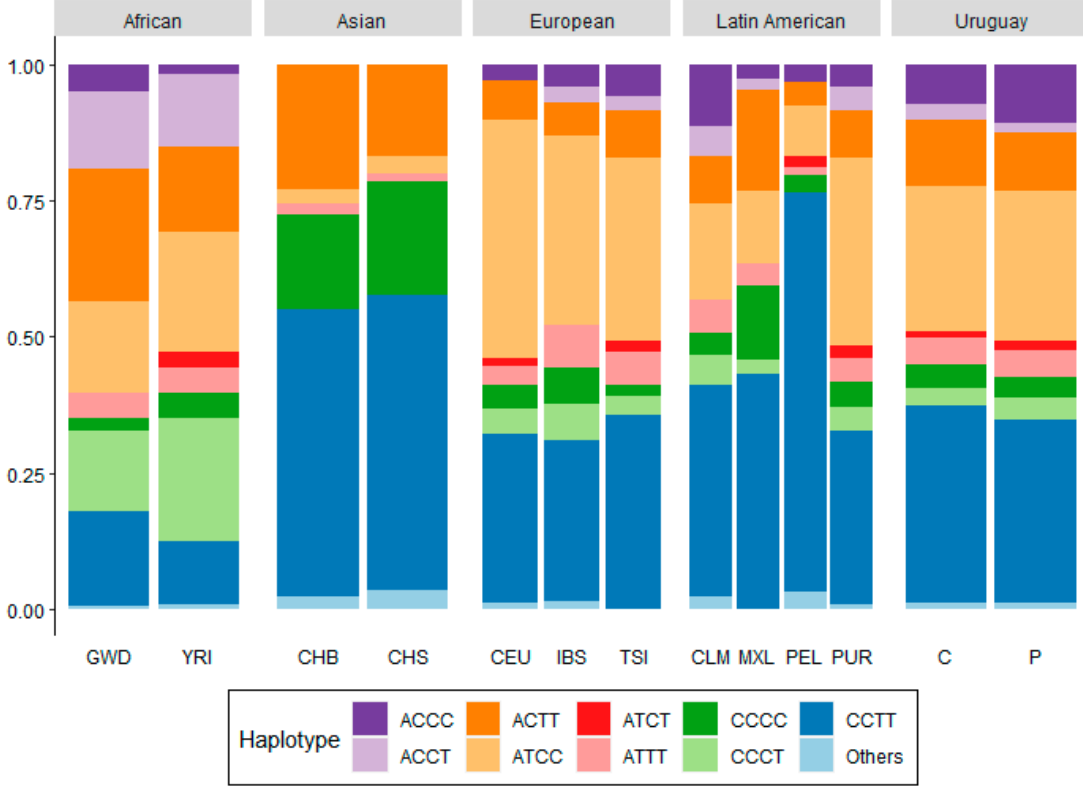
Figure 1 illustrates the geographic distribution of VDR haplotypes (rs7975232|rs1544410|rs2239182|rs2239179). Some differences are remarkable. For example, the VDR